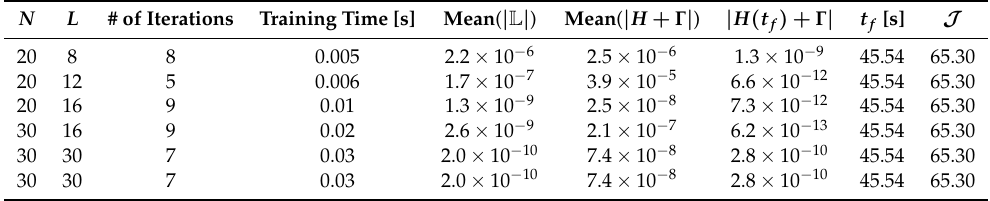
Table 1. Summary of the performances of PoNNs in learning the solutions for the minimum time- energy optimal intercept, with Γ =